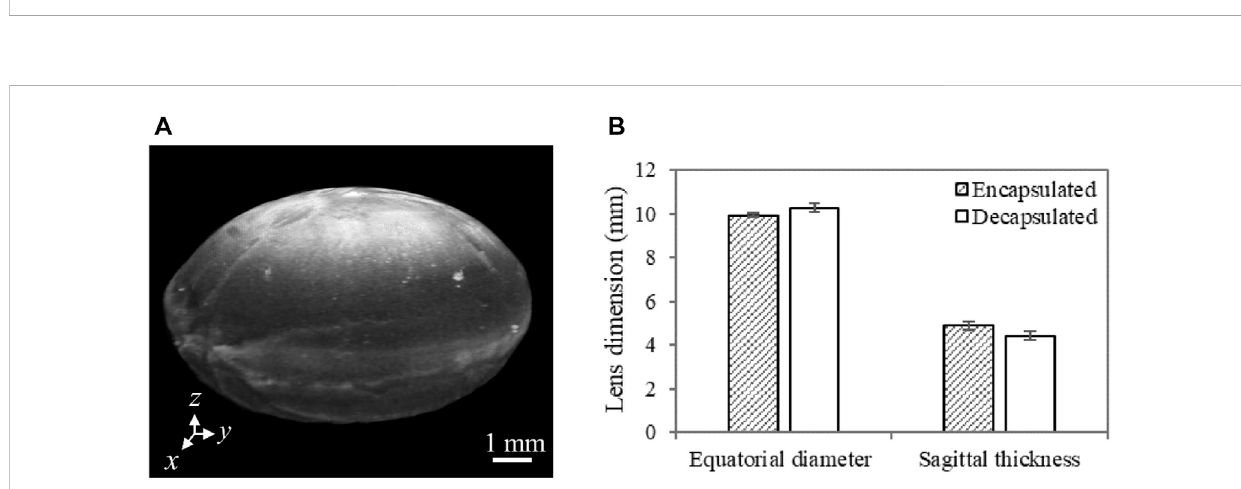
FIGURE 6 (A) A representative 3D OCT image of a dissected porcine lens. The anterior region is facing up (i.e., along the z -axis). Lens sagittal thickness represents the maximum thickness along the anterior-posterior direction (along the z -axis), while the equatorial diameter stands for the maximum thickness along the x -axis or the y -axis. (B) Porcine lens geometric features characterized by the sagittal thickness and equatorial diameter with and without the capsule. For each sample, multiple cross-sectional images (n = 4) extracted from 3D OCT images were used to quantify the mean geometric features. N = 3 for each group of